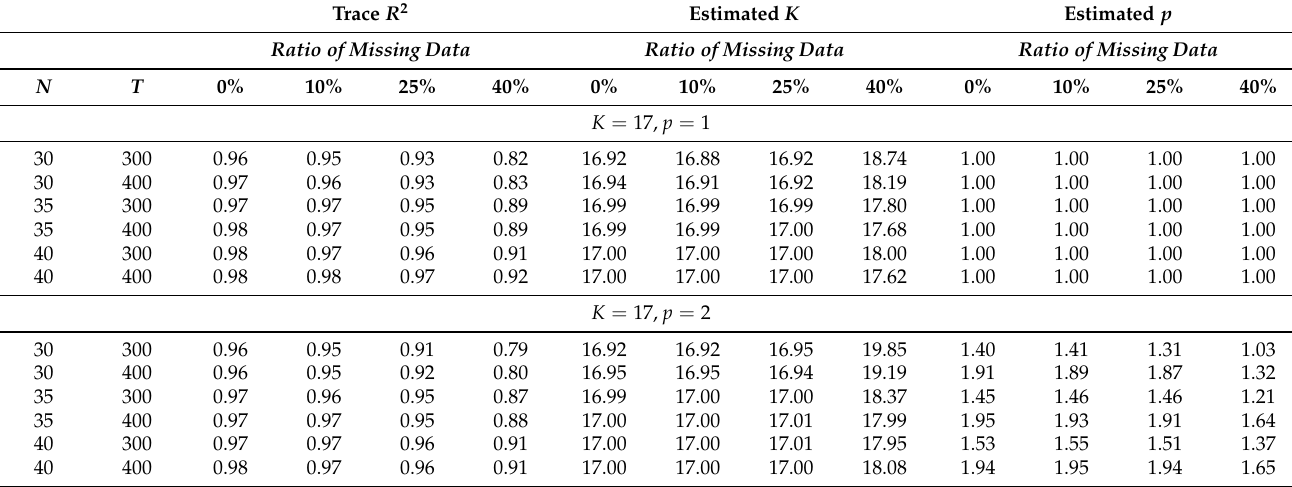
Table A8. Means of trace R 2 for random ADFMs of large dimensions using our two-step estimation method with m = 1